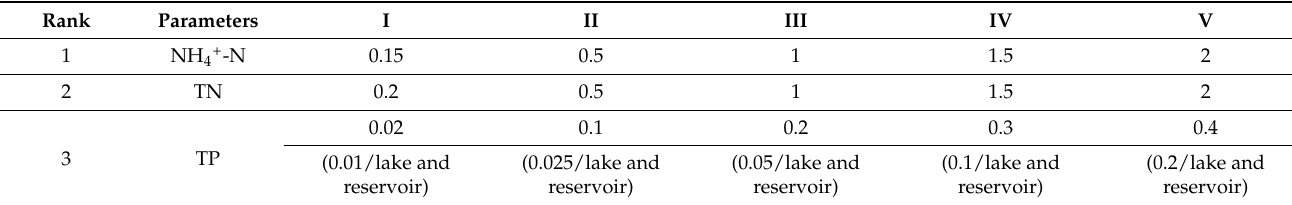
Table 1. Environmental Quality Standards for Surface Water (EQSSW) nutrient water quality standard of China (unit: mg/L). TN: total nitrogen; TP: total